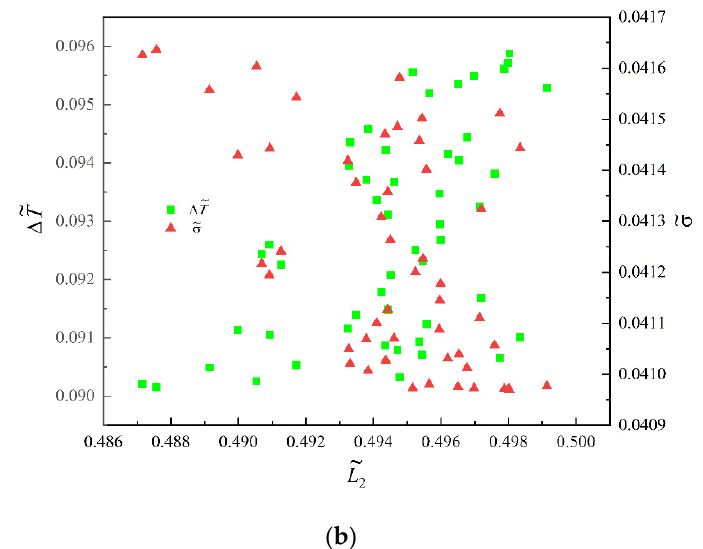
L  and ( b ) L  in the Pareto frontiers under two-DOF optimization. Figure 5. Distributions of ( a ) (cid:101) L 1 and ( b ) (cid:101) L 2 in the Pareto frontiers under two-DOF optimization. 1 2